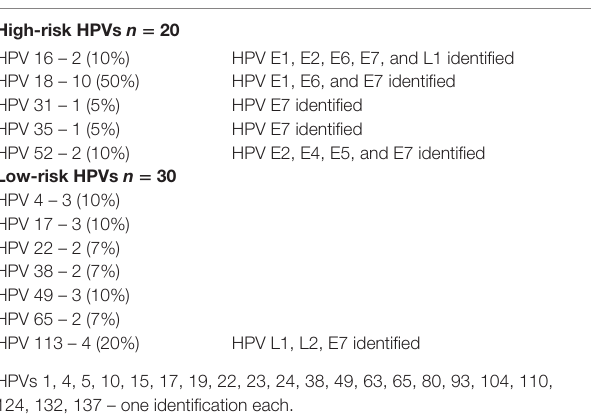
TaBle 1 | hPV types in Tcga breast cancers – next generation